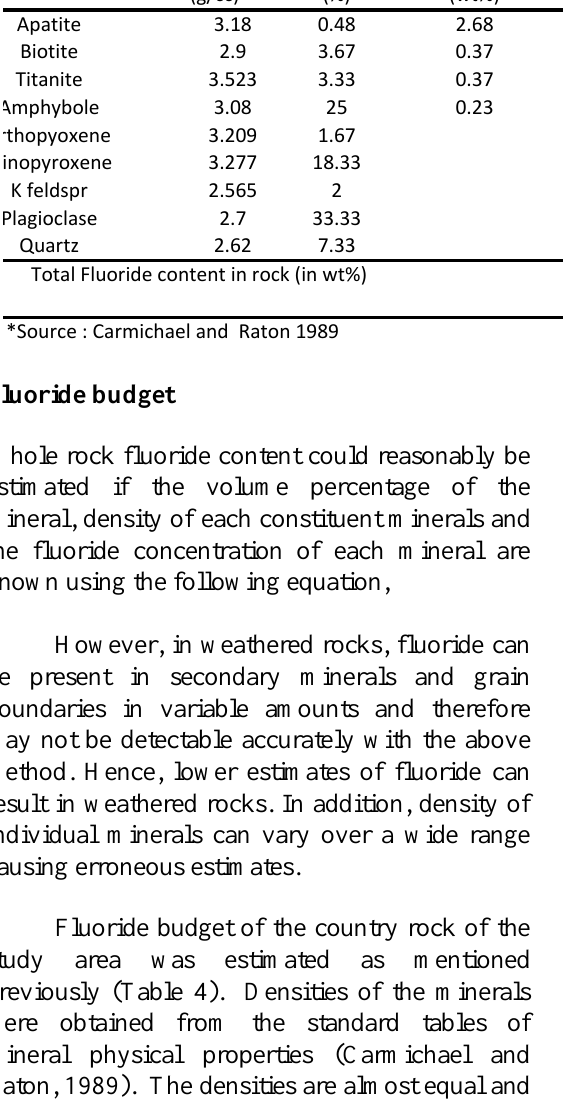
Table 4: Calculated fluoride budget of the country rock of the study area Table 4. Calculated fluorine budget of the country rock of the study area. FRESH ROCK WEATHERED ROCK